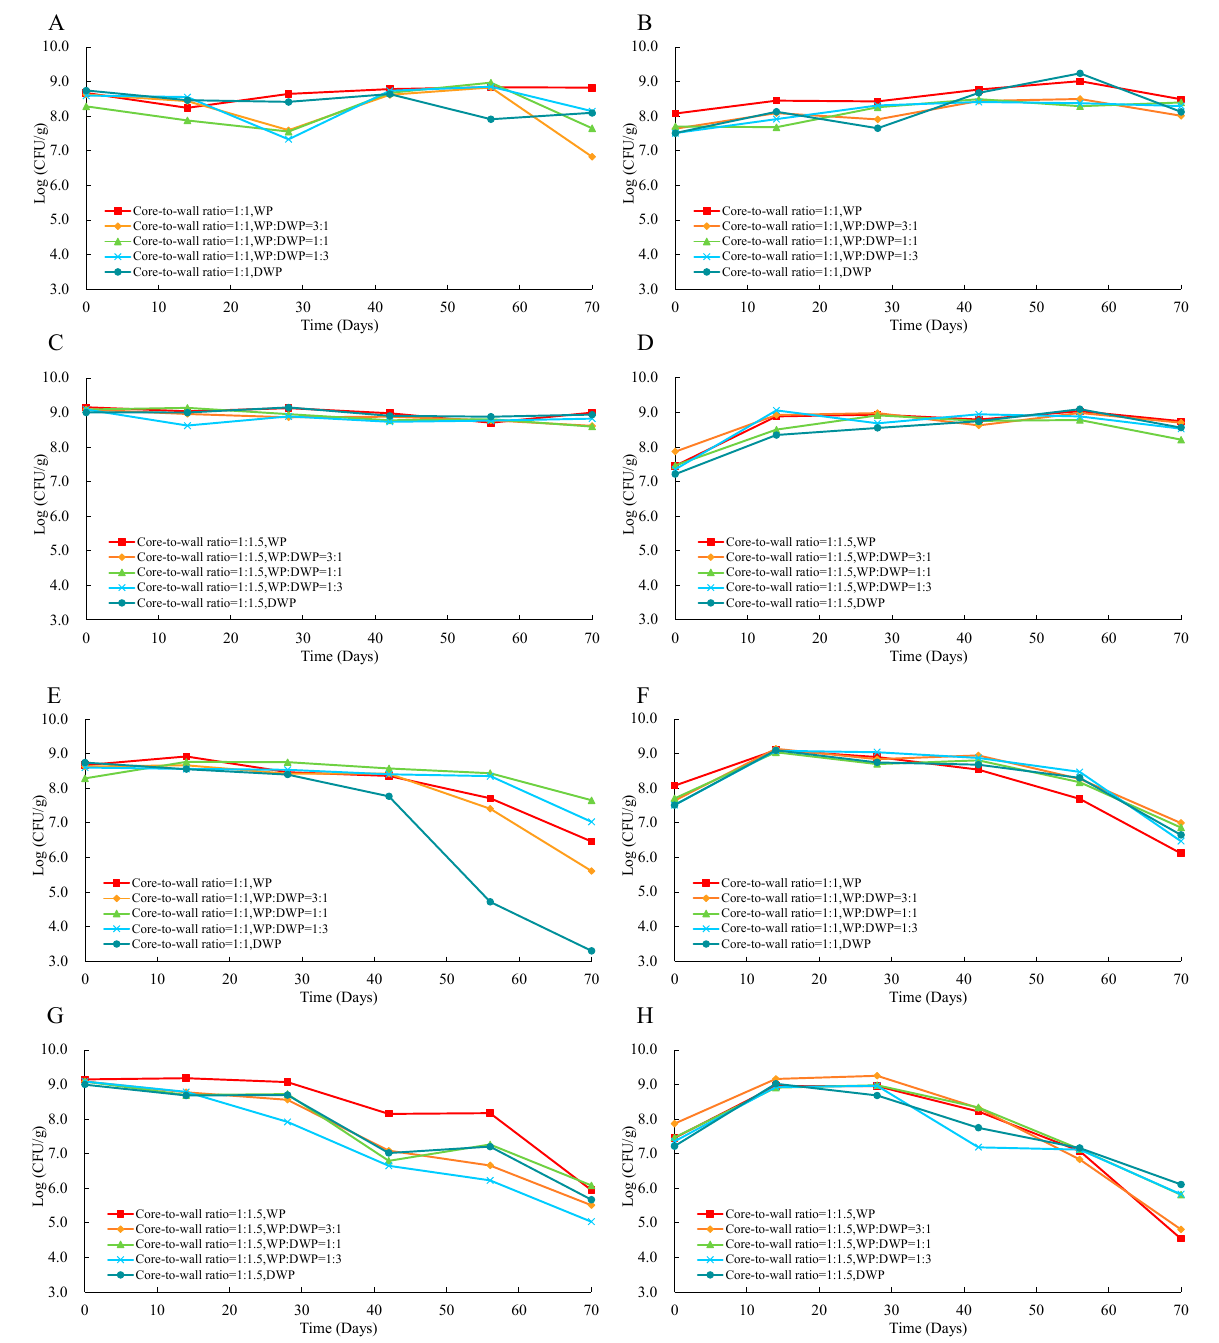
Figure 8. Cell number of fermented and fortified apple juices. ( A ): 4 °C, fermentation, core ‐ to ‐ wall ratio 1:1; ( B ): 4 °C, fortification, core ‐ to ‐ wall ratio 1:1; ( C ): 4 °C, fermentation, core ‐ to ‐ wall ratio 1:1.5; ( D ): 4 °C, fortification, core ‐ to ‐ wall ratio 1:1.5. ( E ): 25 °C, fermentation, core ‐ to ‐ wall ratio 1:1; ( F ): 25 °C, fortification, core ‐ to ‐ wall ratio 1:1; ( G ): 25 °C, fermentation, core ‐ to ‐ wall ratio 1:1.5; ( H ): 25 °C, fortification, core ‐ to ‐ wall ratio 1:1.5. WP: whey protein, DWP: denatured whey protein.